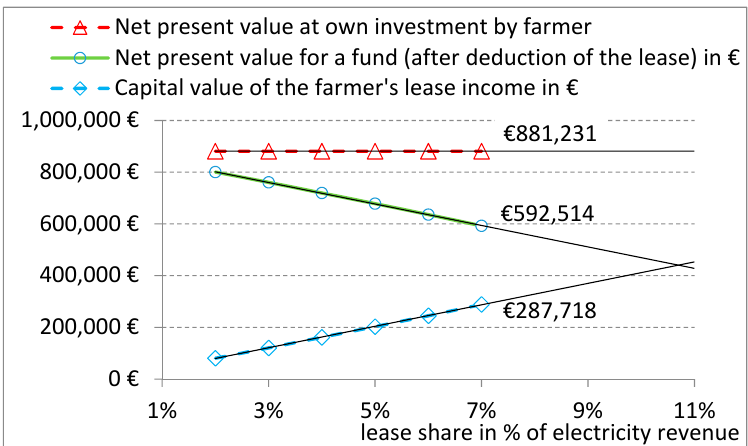
Figure 5. Net present values of the investment of a wind turbine in the case of personal investment by a farmer or an investment fund together with the net present value of the lease payments, the latter depending on the lease share of the electrical revenues. All values are after taxes.